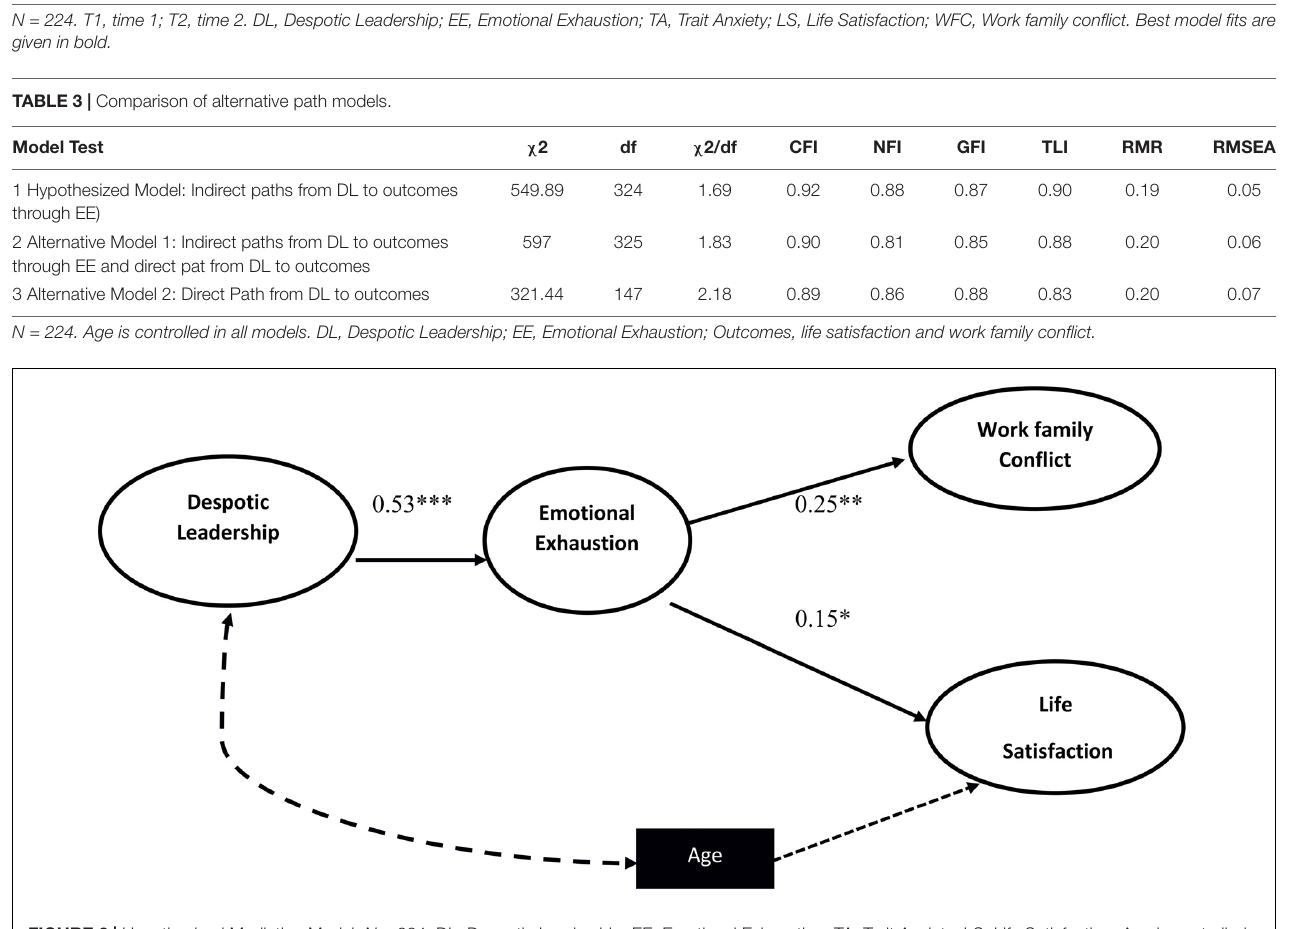
show that the interaction for work-family conflict is stronger when anxiety is high (i.e., β = 0.42, p < 0.001) than when it is low ( β = 0.23, p < 0.001). Similarly, the interaction for life satisfaction is negative when anxiety is